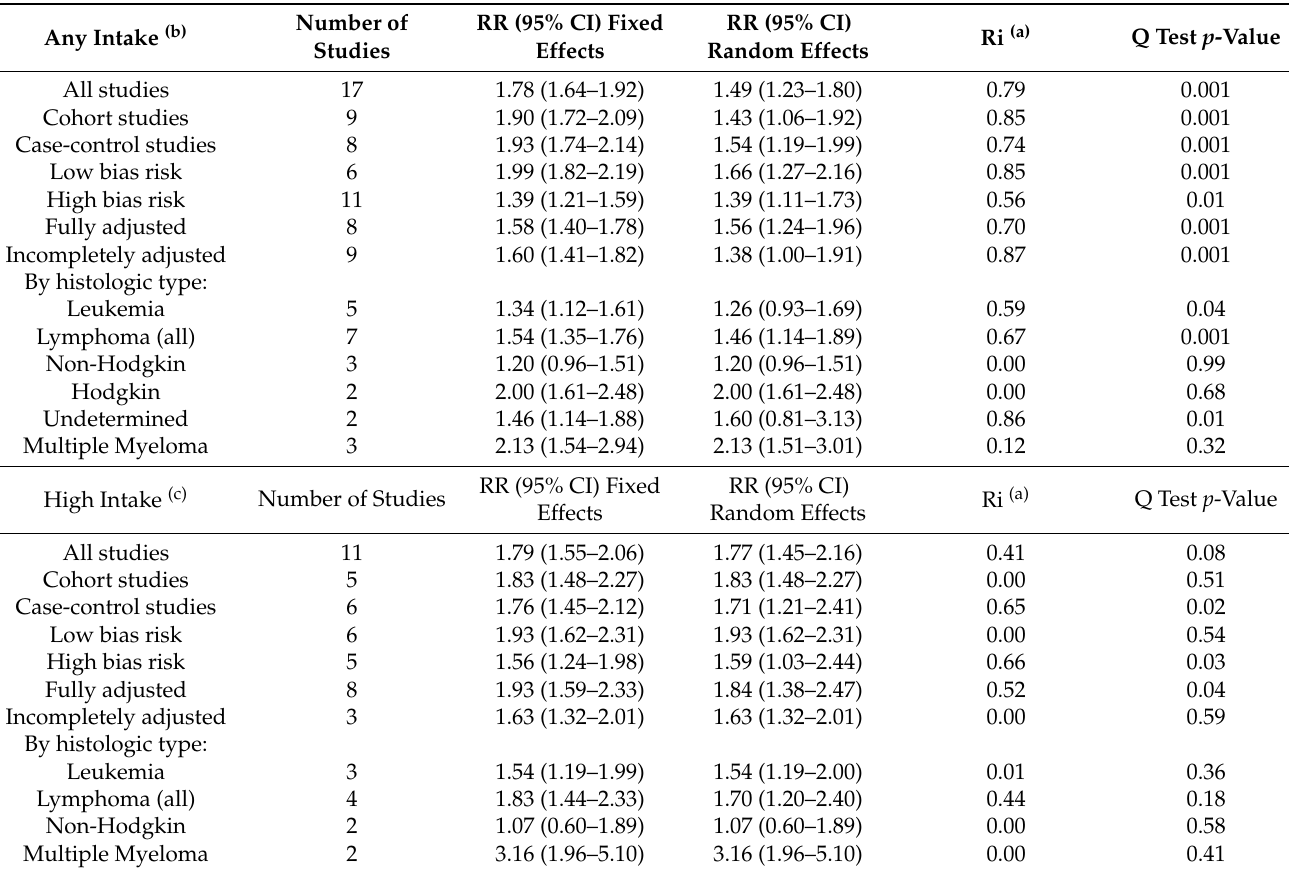
Table 3. Pooled relative risks (RR) and 95% confidence intervals (CI) of paracetamol intake and hematologic